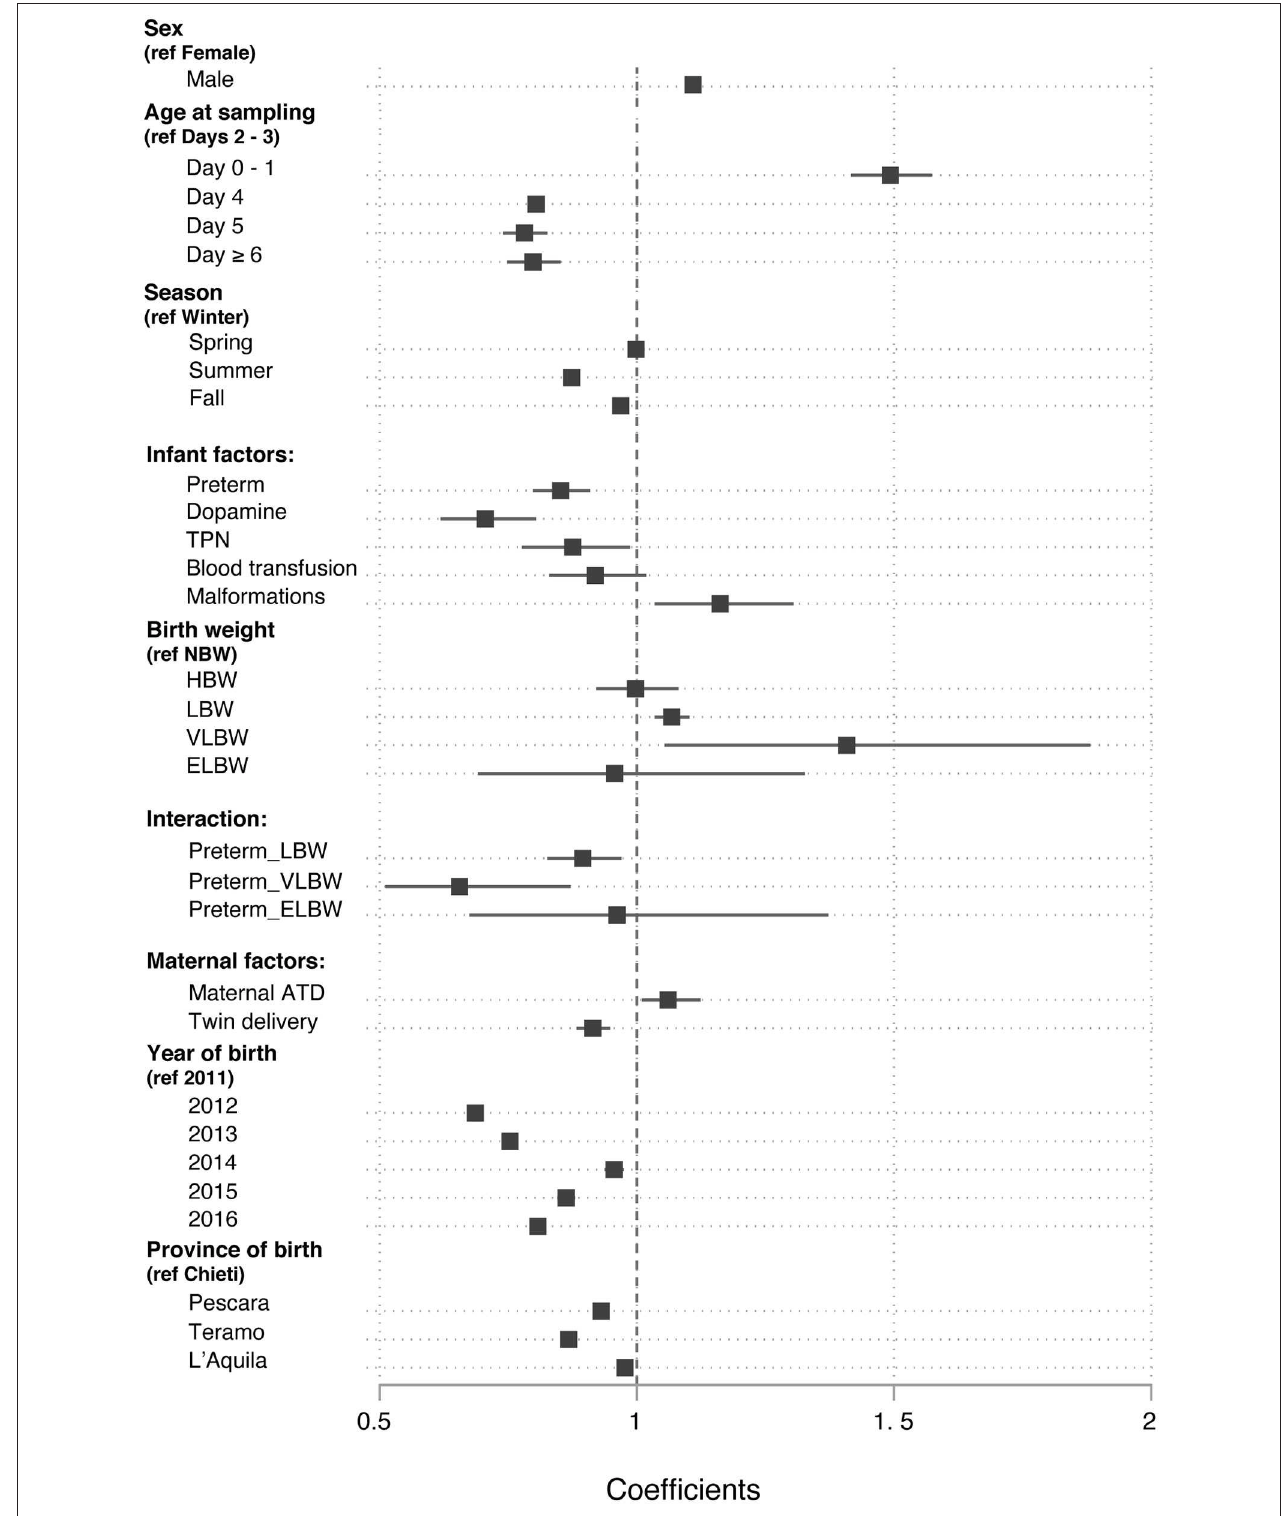
FIGURE 3 | Values of the β regression coefficients in a multiple linear regression model that related the neonatal blood TSH levels to a set of nine covariates.